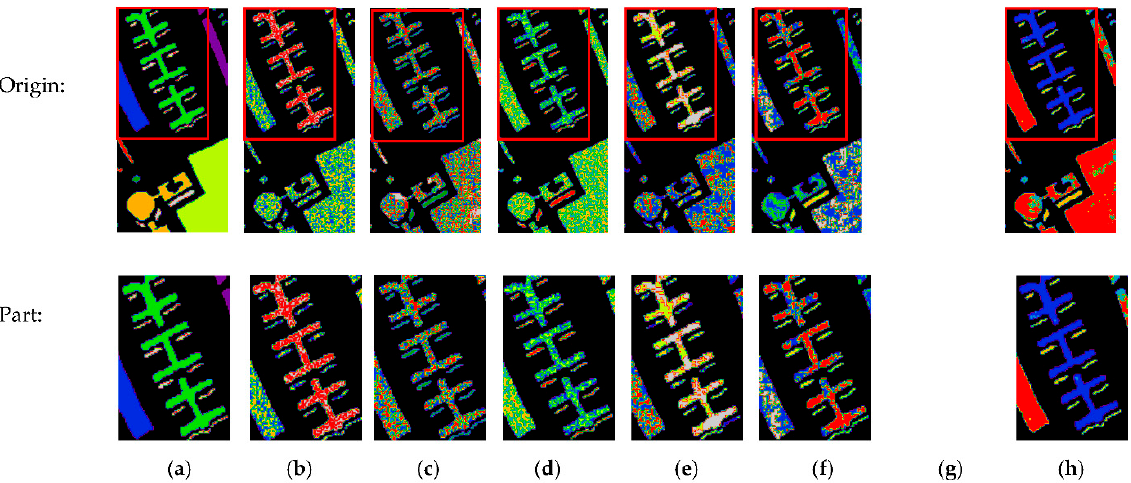
Figure 11. Clustering results obtained using different methods on the Indian Pines corrected data set with Gaussian noise. ( a ) Ground truth. ( b ) LRSC 43.20%. ( c ) SSC 42.20%. ( d ) S4C 53.29%. ( e ) EDSC 56.78%. ( f ) EGCSC 59.30%. ( g ) EKGCSC 54.70%. ( h ) SSAKGCSC 64.95%.